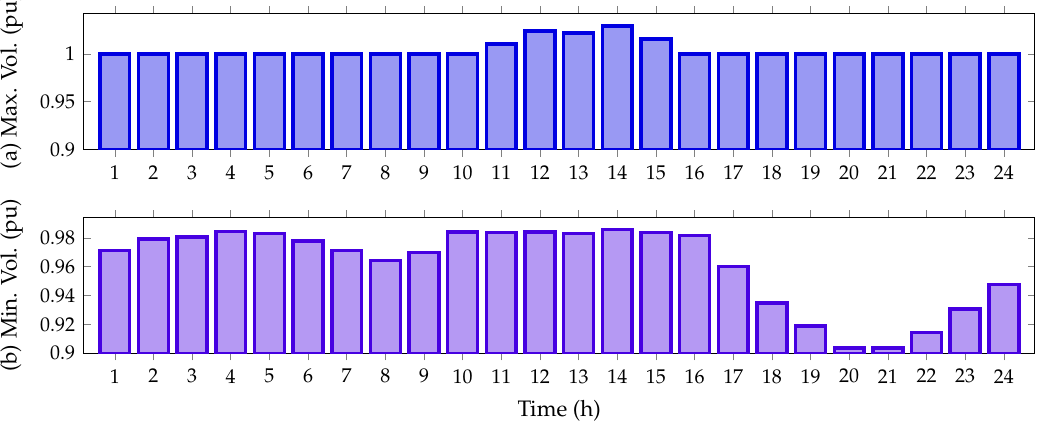
Figure 6. Voltage behavior during the day for the IEEE 33-bus system: ( a ) maximum voltage magnitude, and ( b ) minimum voltage magnitude.